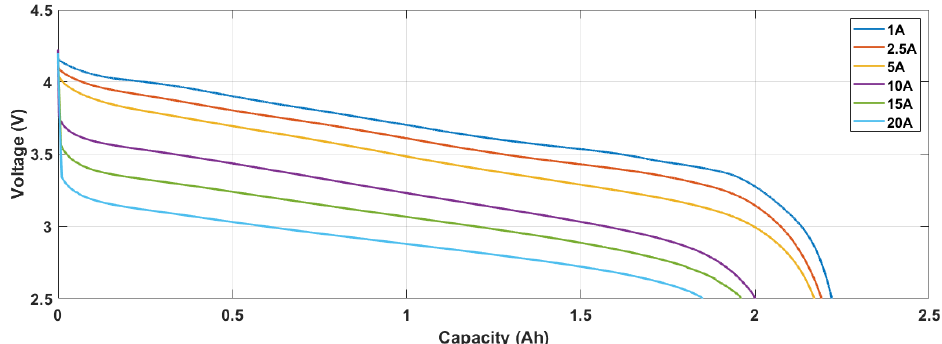
Figure 9. Discharge characteristics for SoH = 89%.